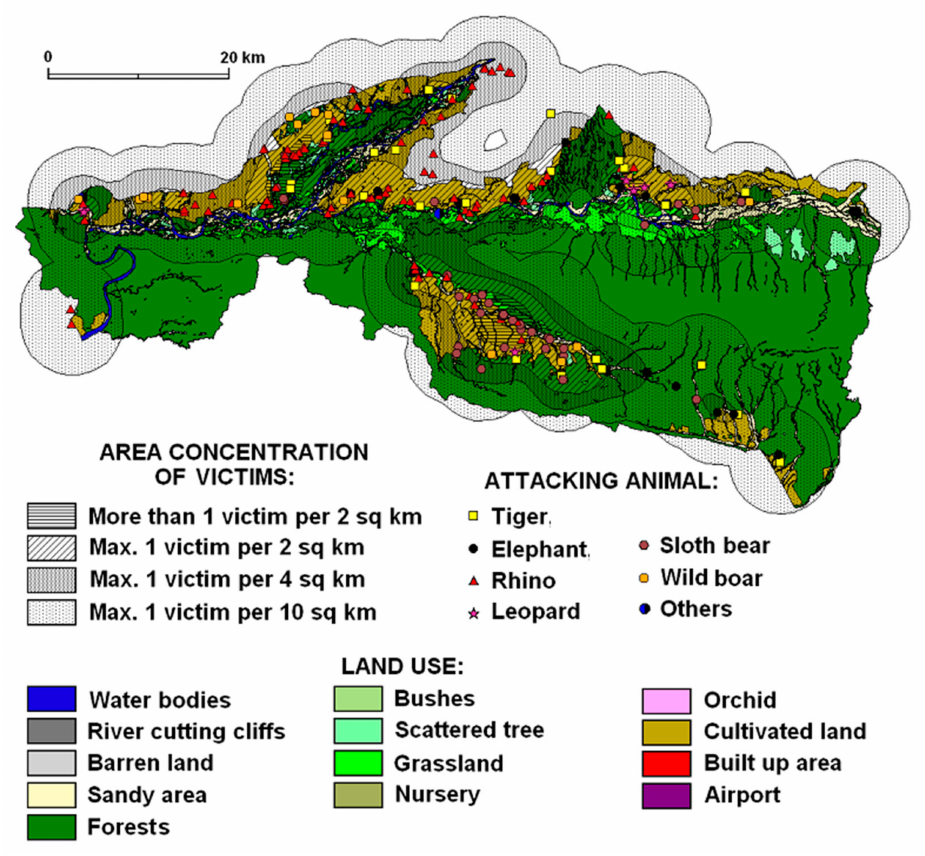
Figure 2. Spatial distribution of wildlife attacks on humans in Chitwan National